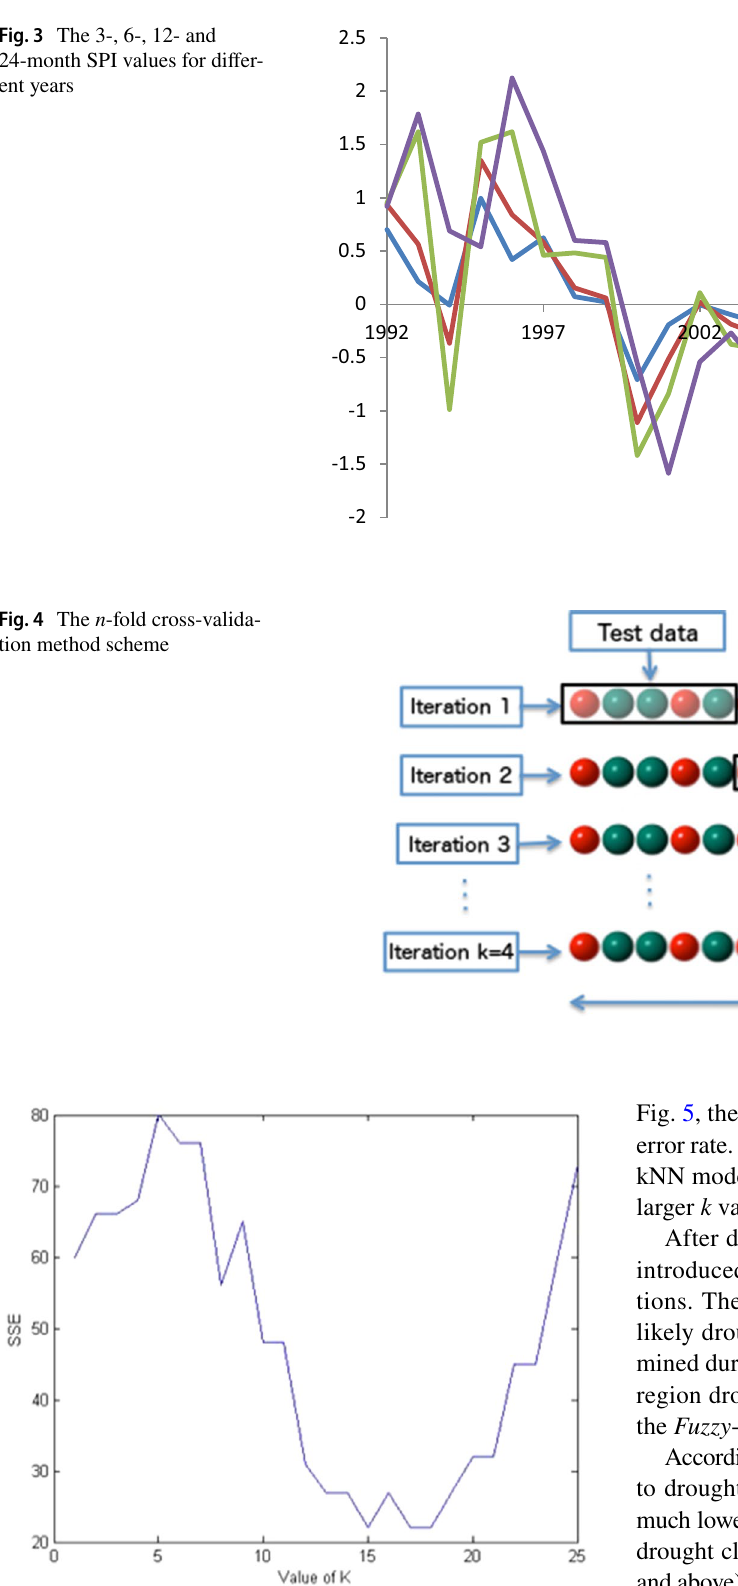
Fig. 3 The 3-, 6-, 12- and 24-month SPI values for differ- ent years